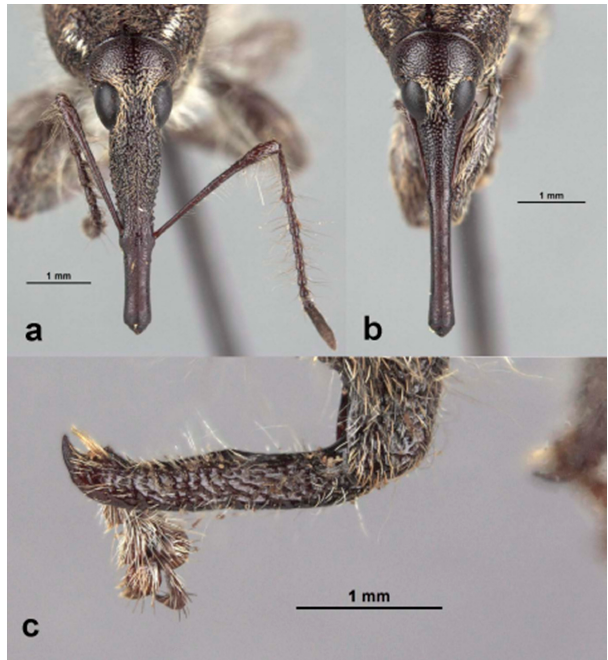
Figure 14. Kuschelorhinus hirsutus : ( a ) rostrum of male, dorsal aspect; ( b ) rostrum of female, dorsal aspect; ( c ) protibia of male, anterior aspect.